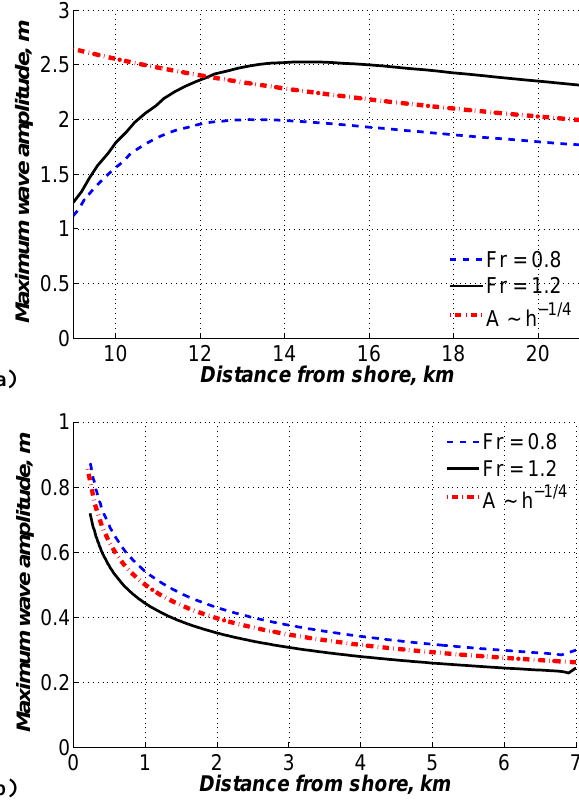
Fig. 6. Variations of the maximum amplitude of tsunami waves during its propagation along the bottom profile h ∼ x 4 / 3 : for positive waves propagating offshore (a) and onshore (b)